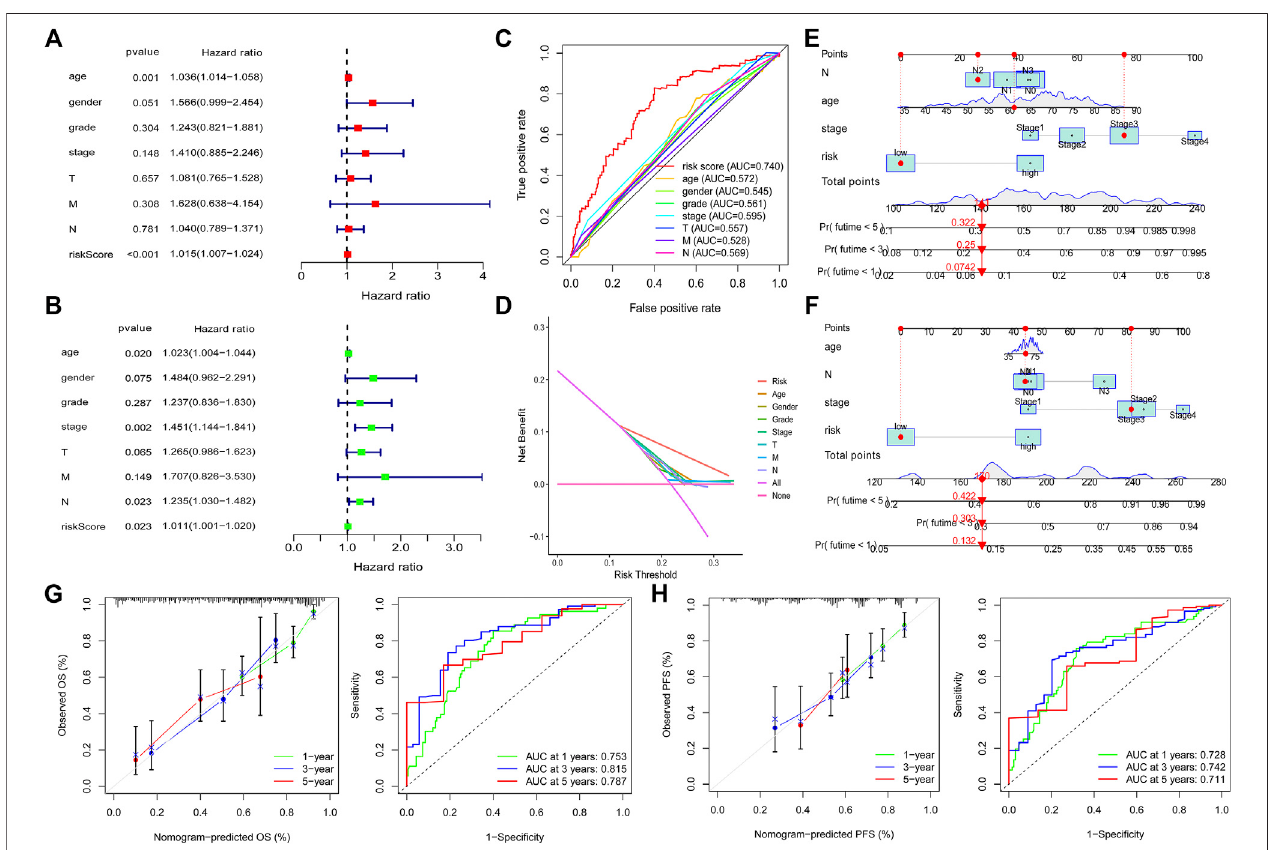
FIGURE 4 | Independent prognosis value of the risk model. Univariate analysis and multivariable analysis were conducted to validate the independent prognosis value of the model (A,B) . Roc curves were performed to validate the superiority of the risk score in predicting patient ’ survival (C) . Decision curve analysis (DCA) was conducted tocon fi rm thesuperiority ofthe riskscore in the clinical application (D) . Nomogram was plotted for the prediction of overall survival time (E) and progression- freesurvivaltime (F) inGCpatients.ThecalibrationcurvesandROCcurveswerefurtherplottedtodeterminetheaccuracyofthenomogramforOSandPFSat1,3 and 5 years, respectively (G,H)